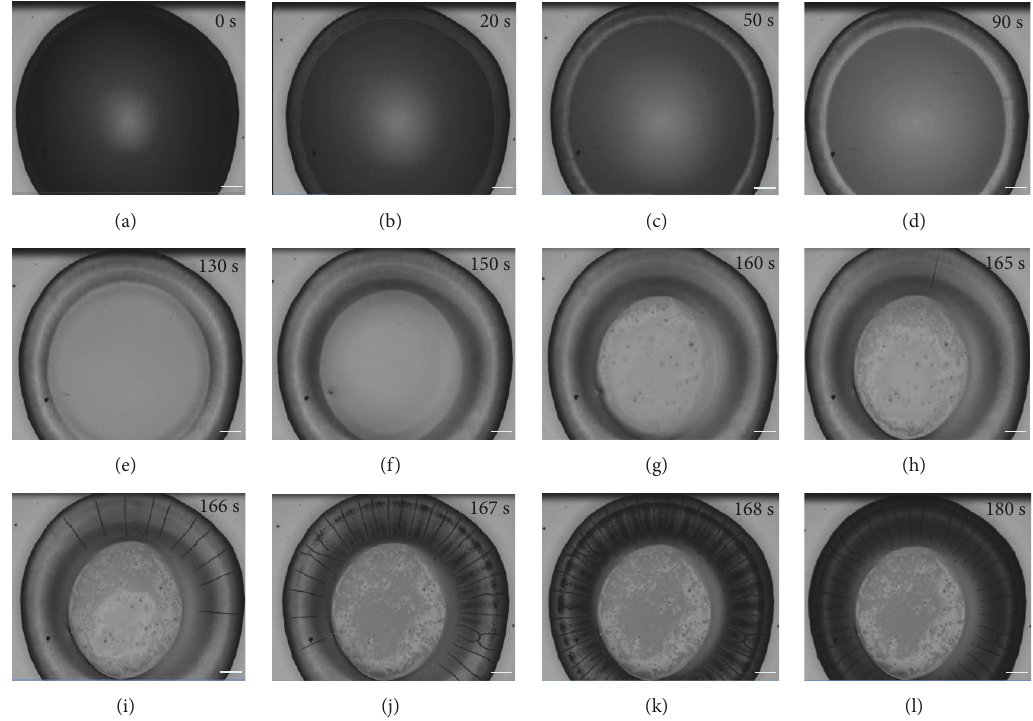
Figure 4: Evaporation dynamics of a PTFE droplet on a smooth substrate. Panels (a)–(l) correspond to different evaporation times (scale bars represent 100 𝜇